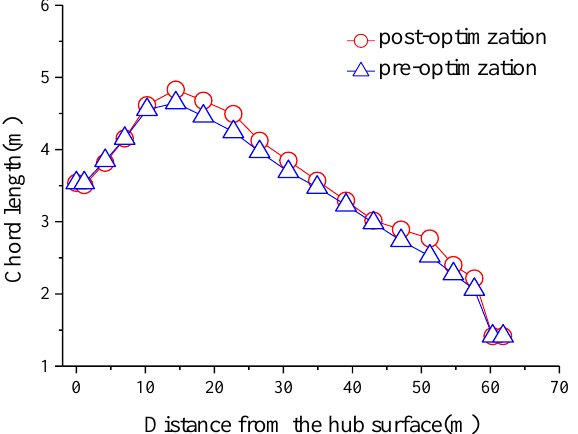
Figure 4. Distribution of the chord length for fixed wind turbine blade at rated wind speed before and after optimization.